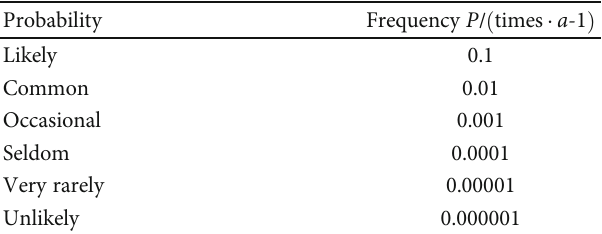
Table 2: Accident probability standard